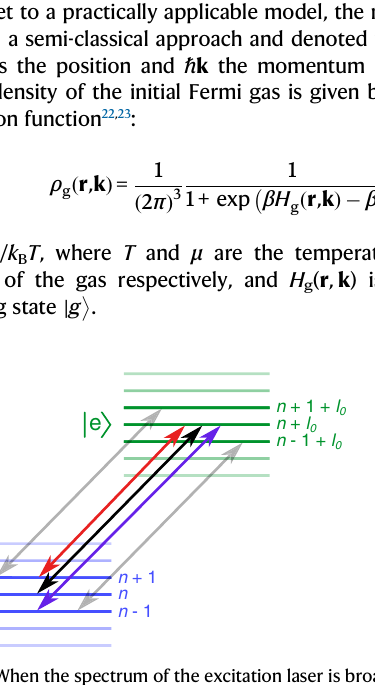
arrows). b When the spectrum of the excitation laser is broader than the energy splitting of the vibrational states, several other transitions are possible too (side- band transitions, represented as red and blue